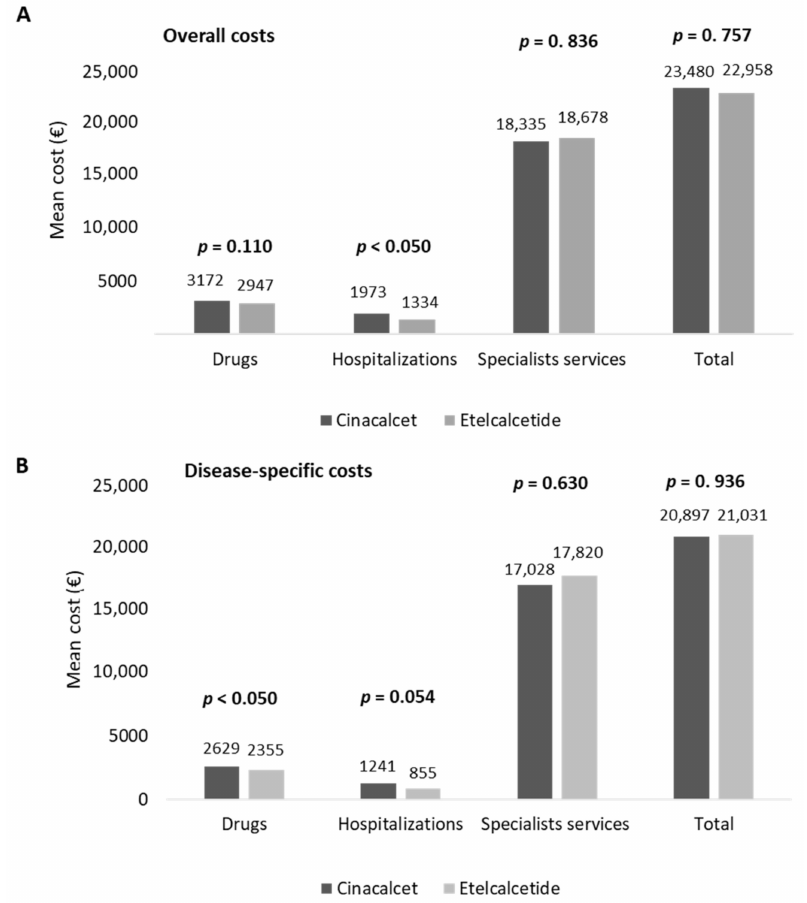
Figure 3. Healthcare mean total costs related to overall ( A ) and disease-specific ( B ) resource con- sumption in cinacalcet- and etelcalcetide-treated cohorts,